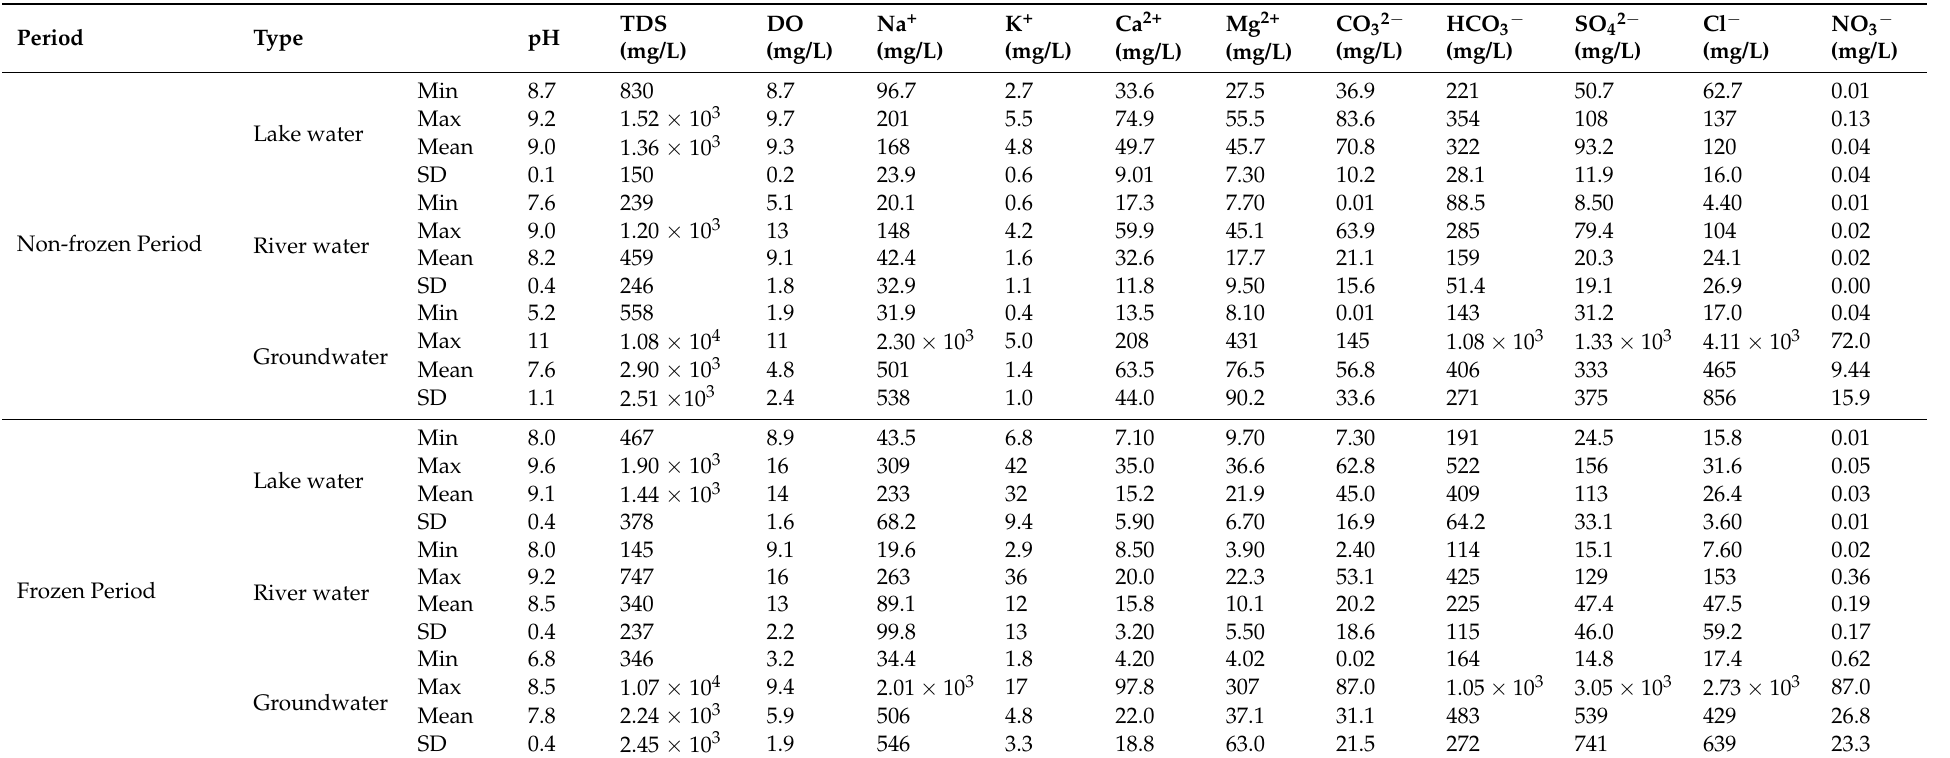
Table 1. Results of water chemistry analysis during the frozen and non-frozen seasons in the Hulun Lake